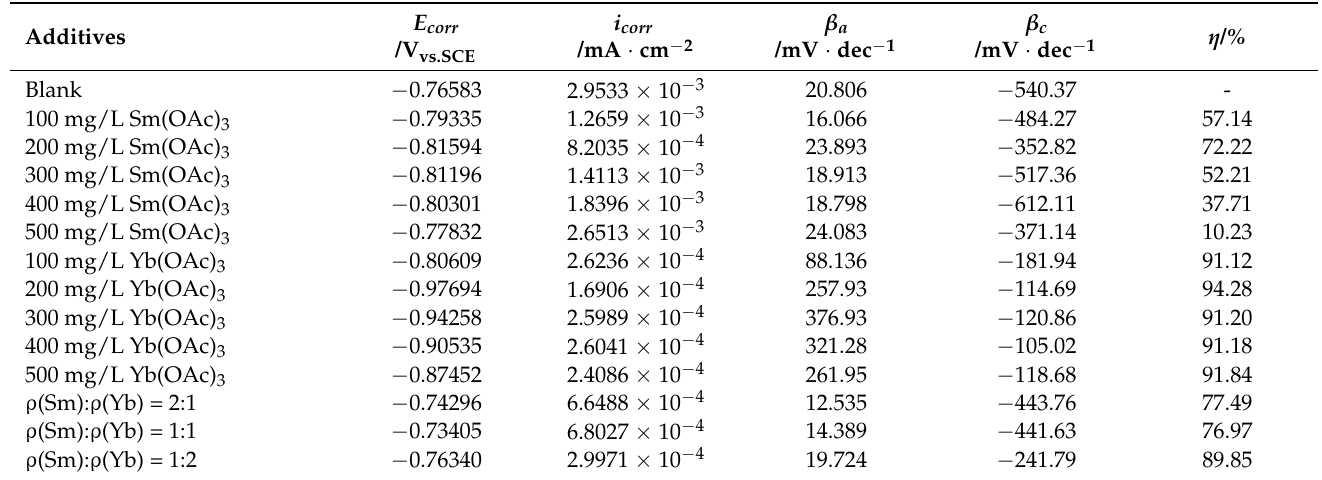
Table 1. Electrochemical parameters obtained from polarization curves for aluminum anode in 3.5 wt.% NaCl solution with different